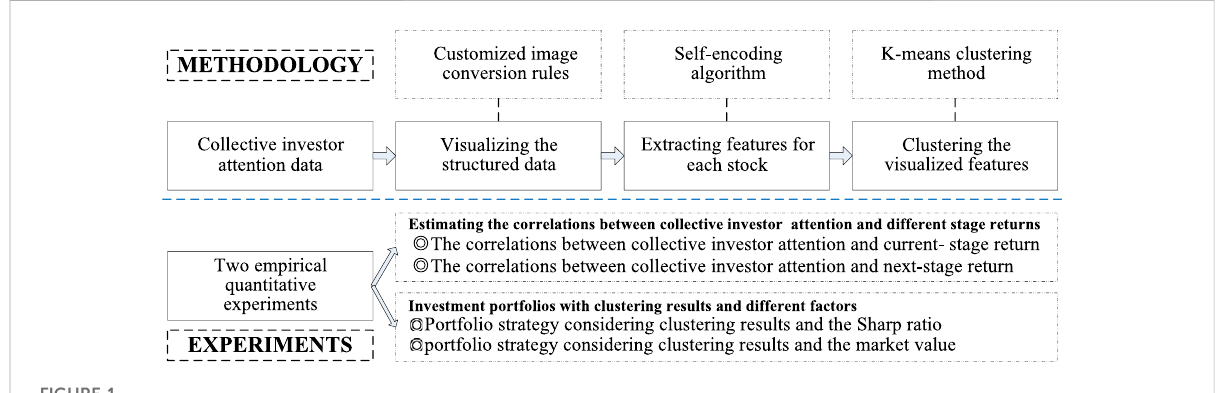
FIGURE 1 Structure framework of this work.